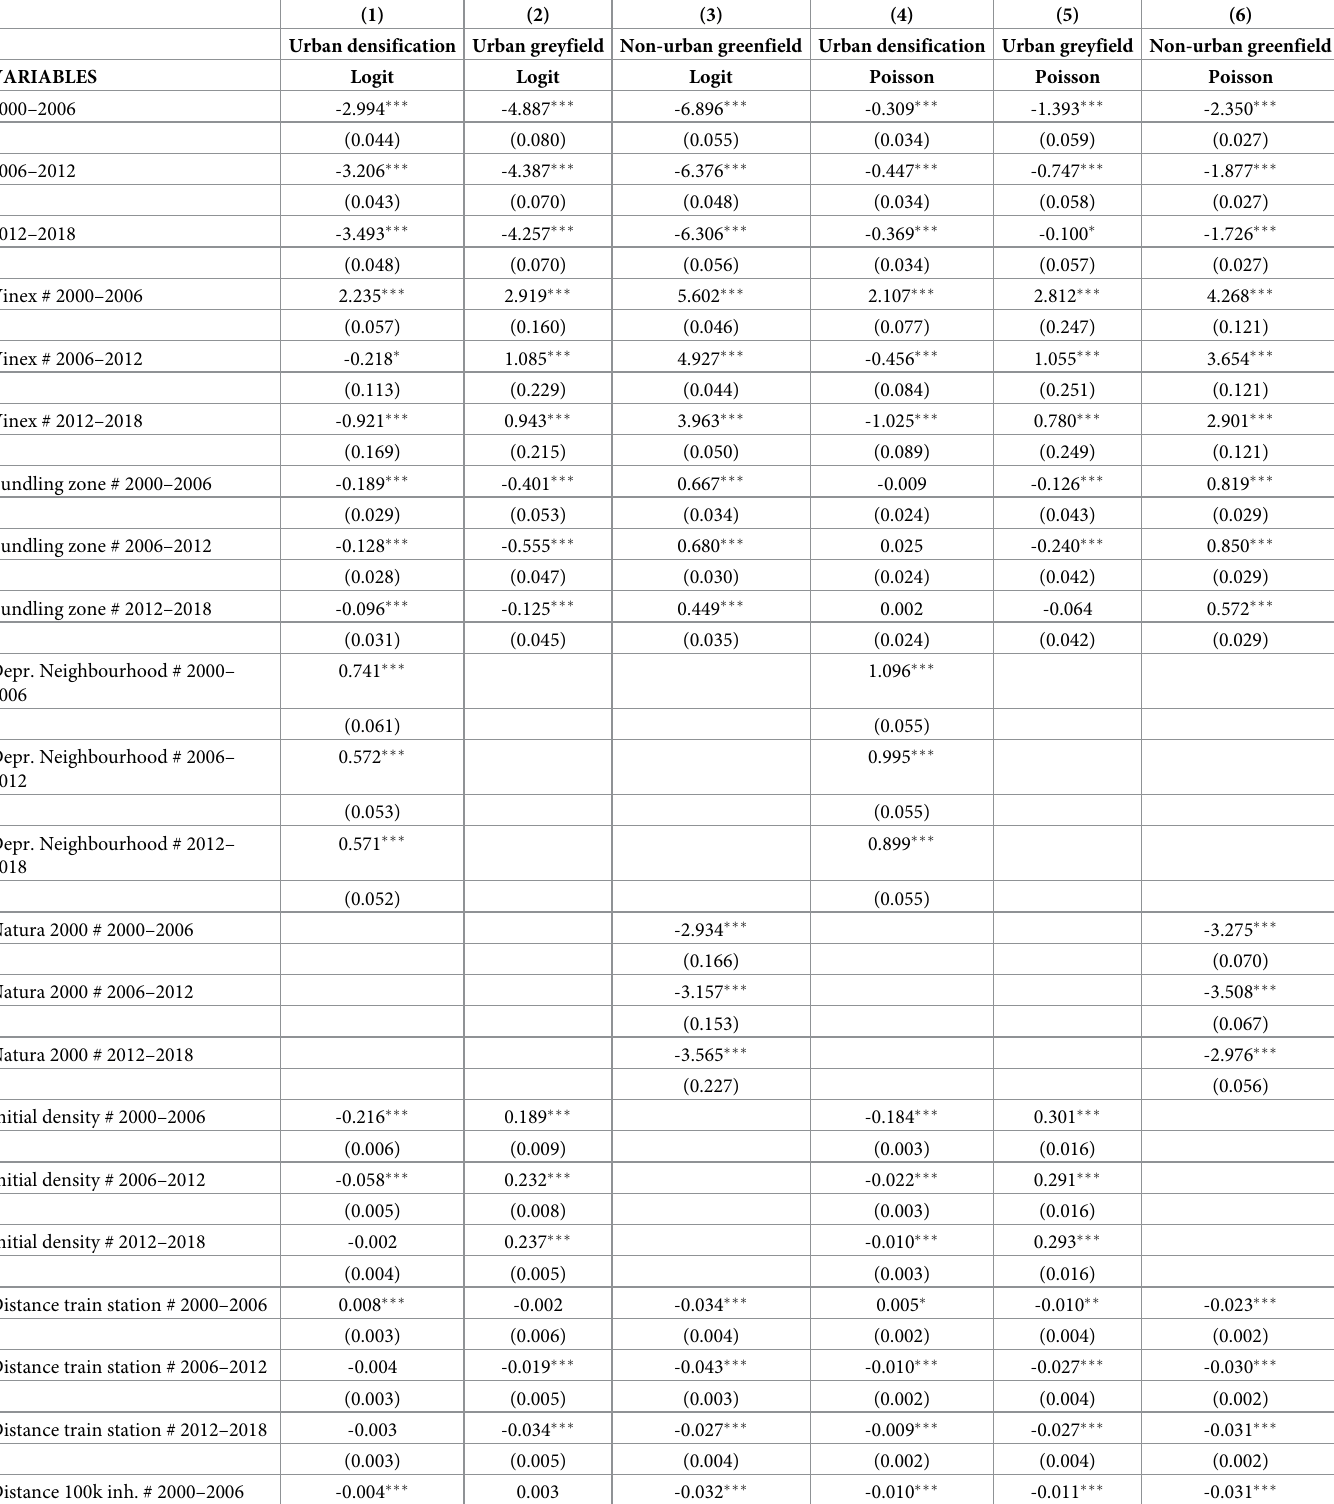
Table 4. Regression results for the three main development processes, with policy measures and control